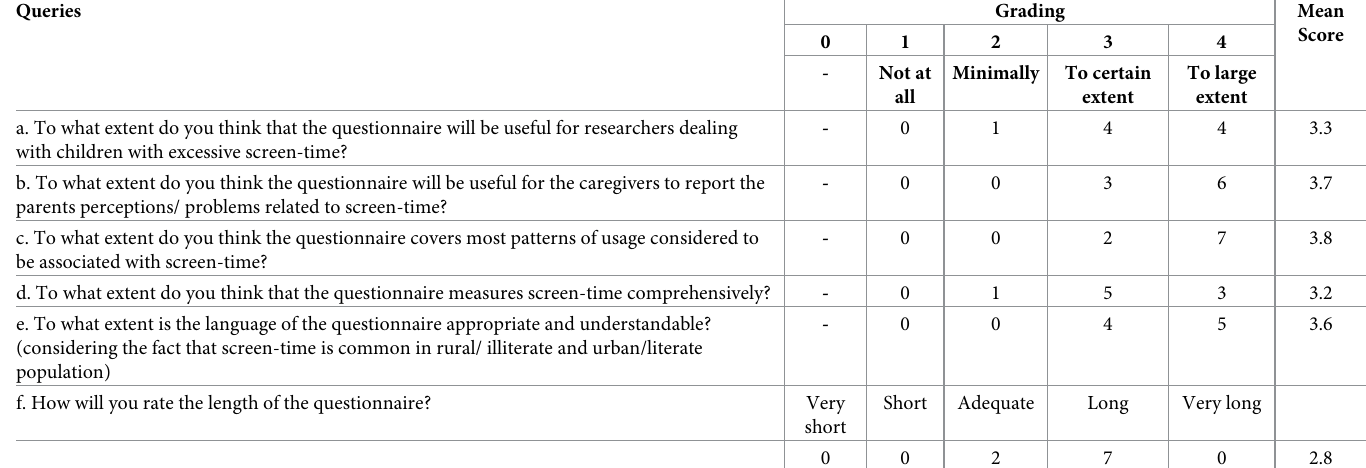
Table 2. Mean ratings of the content and face validation by experts of the digital screen exposure questionnaire.